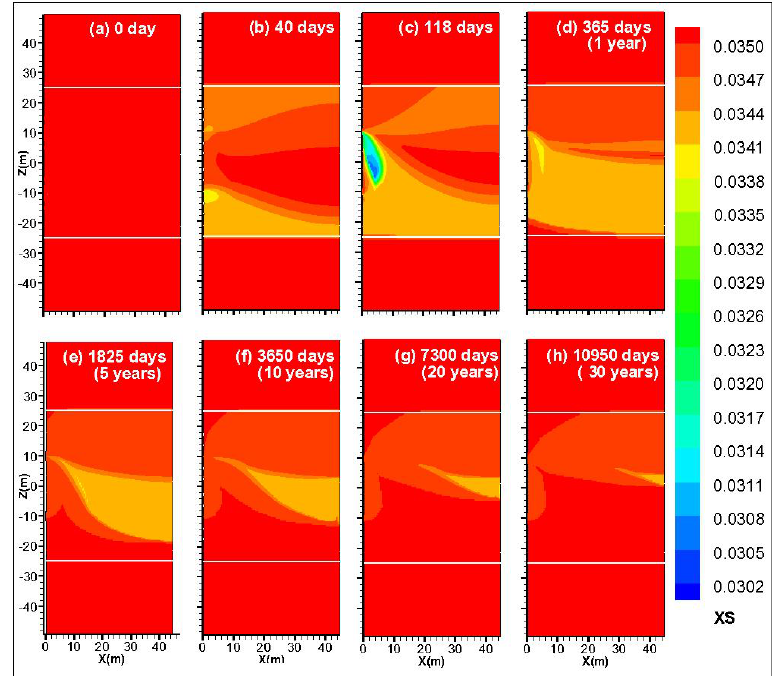
Figure 8. Evolution of the spatial distribution of X Reference